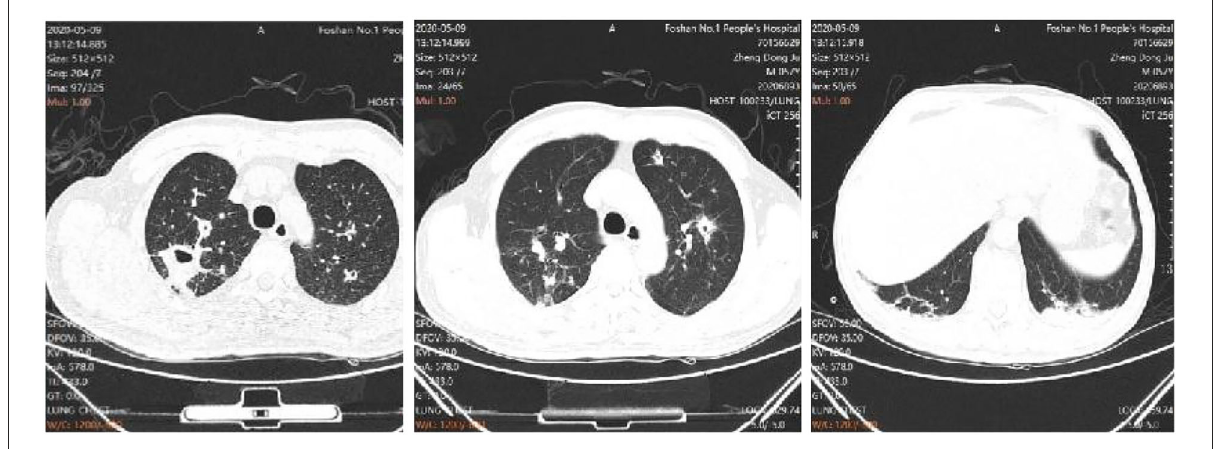
FIGURE4 Imaging of the lungs after